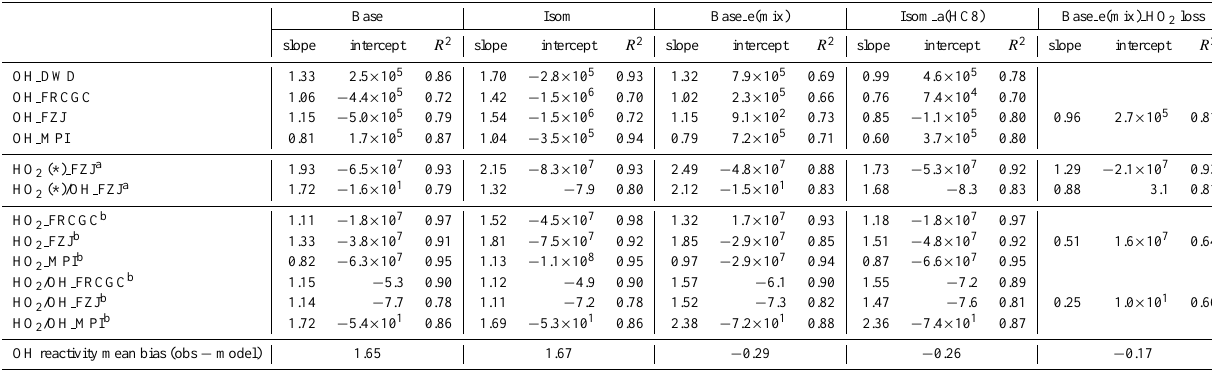
Table 3. Linear-regression parameters for daytime (defined as 06:00–18:00UTC). Slopes larger than unity indicate model overestimation. Intercepts are for the y -axis for model values. Base Isom Base e(mix) Isom a(HC8) Base e(mix) HO 2 loss slope intercept R 2 slope intercept R 2 slope intercept R 2 slope intercept R 2 slope intercept R 2 OH